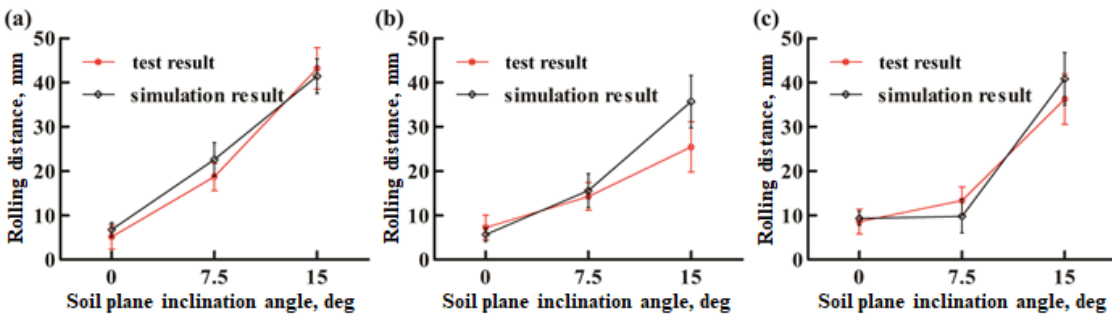
Figure 12. The relationship between rolling distance and soil plane inclination angle for ( a ) SN42, ( b ) JD17 and ( c ) ZD39.